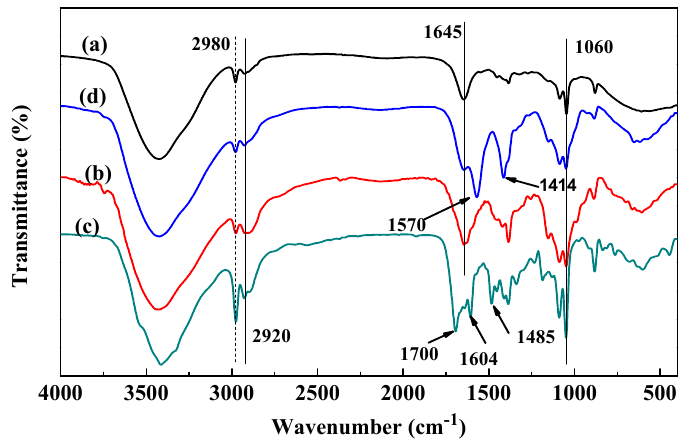
Figure 3. Fourier transform infrared (FT-IR) spectra of ( a ) chitosan, ( b ) AmCS, ( c ) FA, and ( d ) FA-AmCS-TPP nanoparticles.